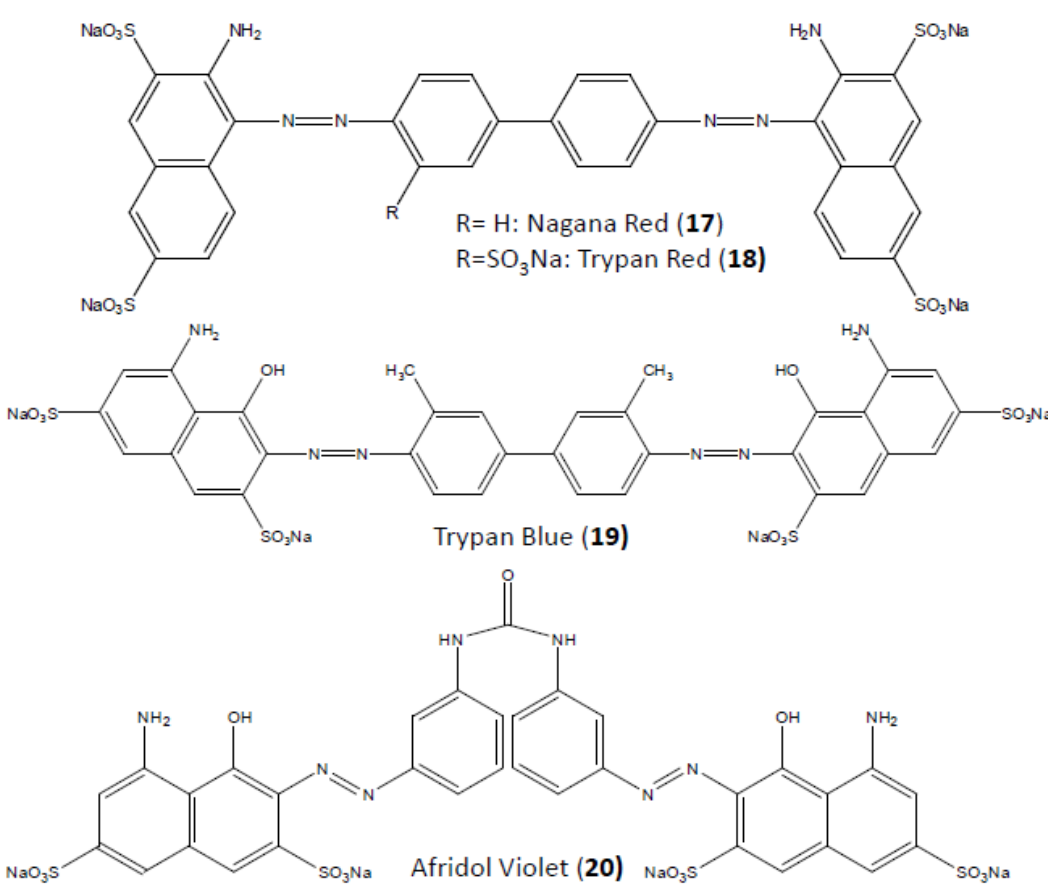
Figure 1. Structural formulas of trypanocides.